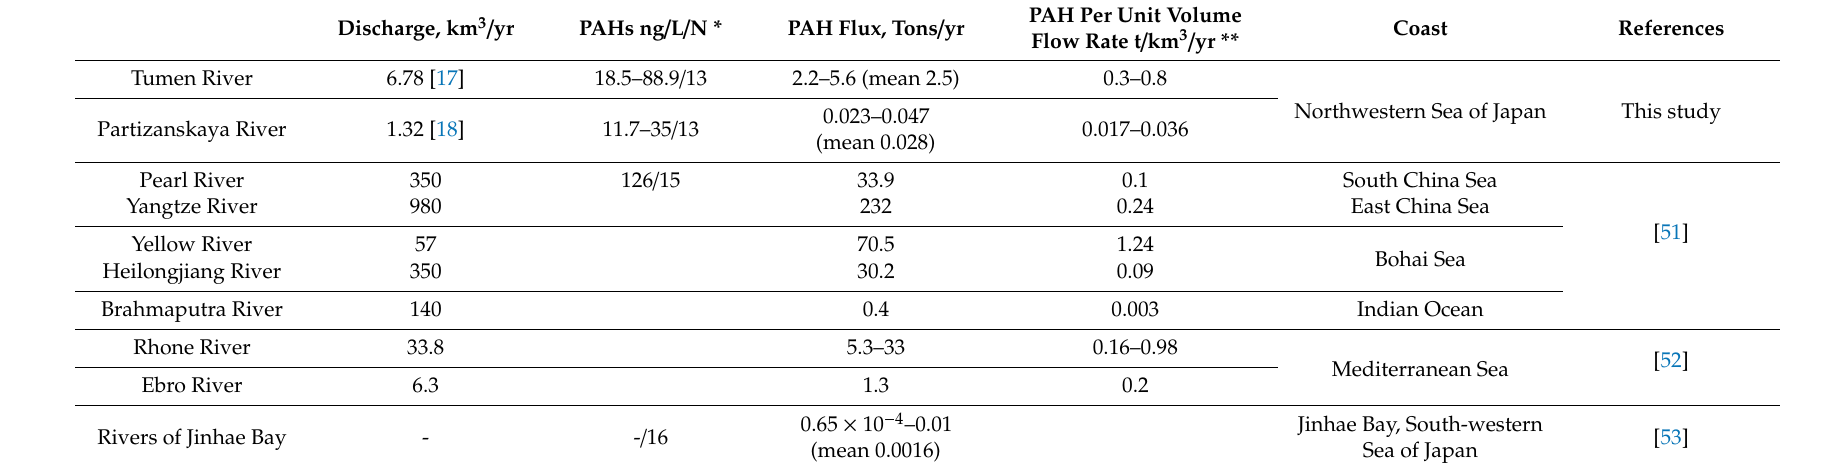
Table 5. PAHs concentrations, river discharge, and fluxes of PAHs from global